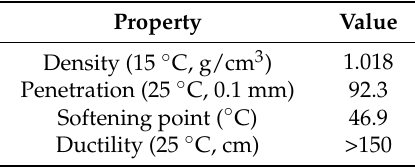
Figure 2. Images of diatomite. ( a ) Morphology of diatomite; ( b ) SEM images of diatomite . Table 1. Basic properties of AH-90 asphalt.